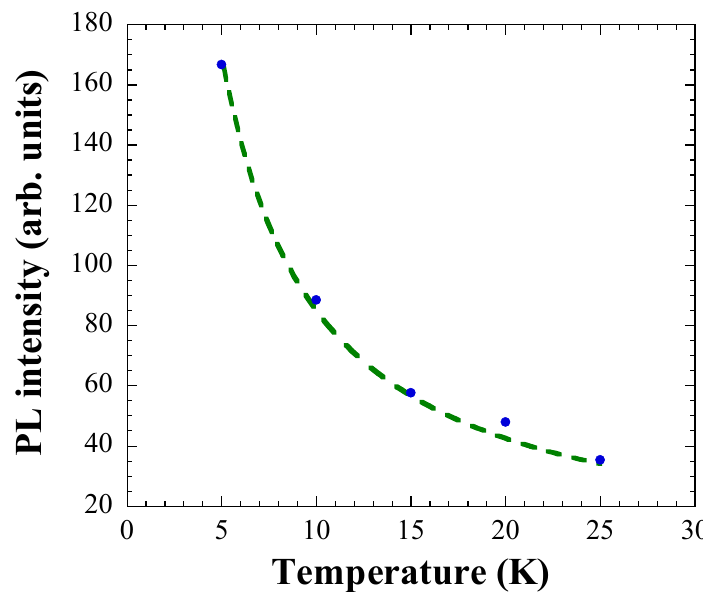
Figure 3. PL intensity versus temperature of the spectra in Figure 2. The dashed line is a fit proportional to 1/ T .